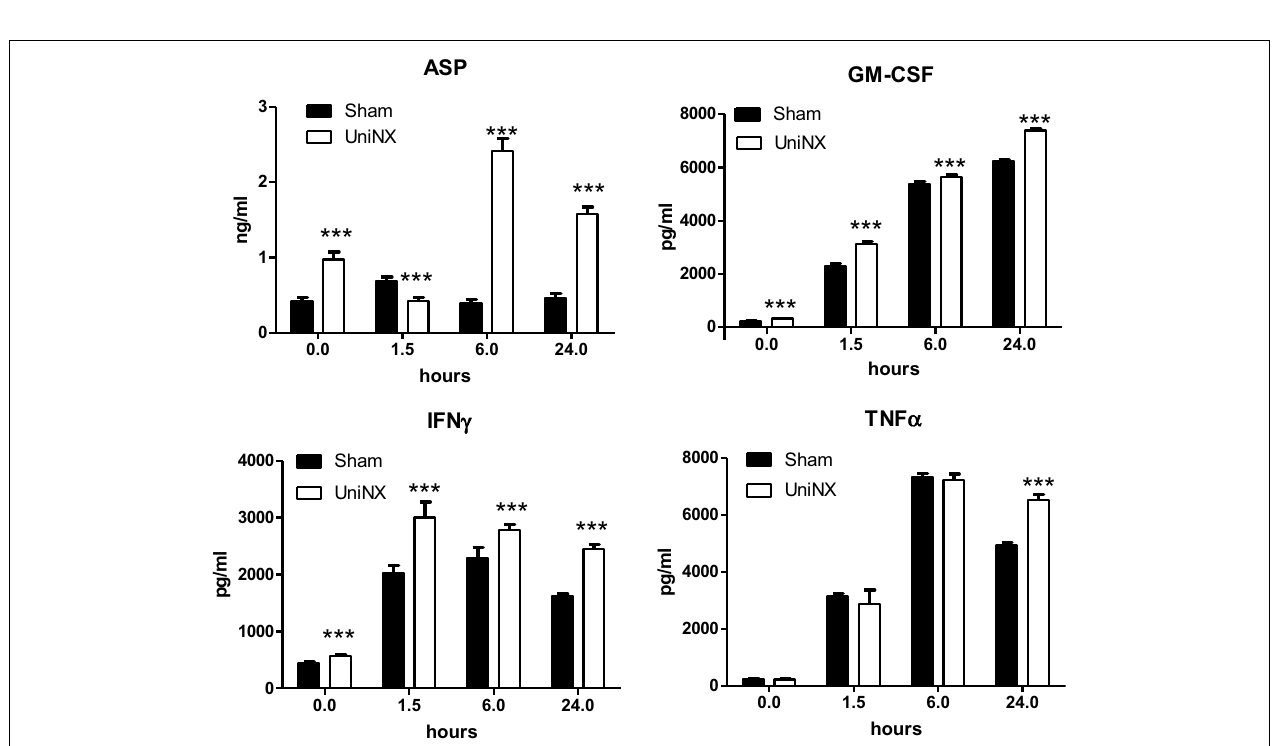
FIGURE 4 | Circulating levels of ASP, GM-CSF, IFN γγγ , and TNF ααα , in Sham-operated and UniNX rats 1.5, 6, and 24h after i.p. LPS injection . Values are means (cid:6) SE; n = 8/group. *** p < 0.001 corresponds to Sham vs. UniNX.